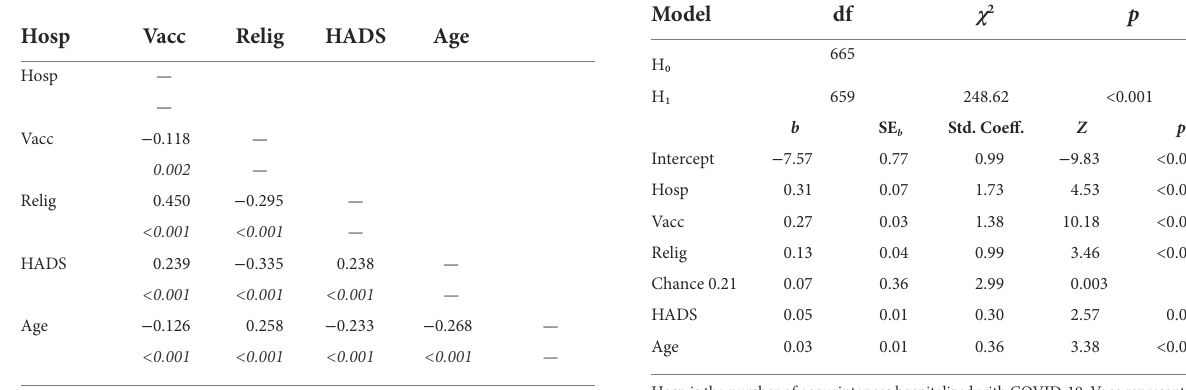
TABLE 5 Logistic regression analysis predicting